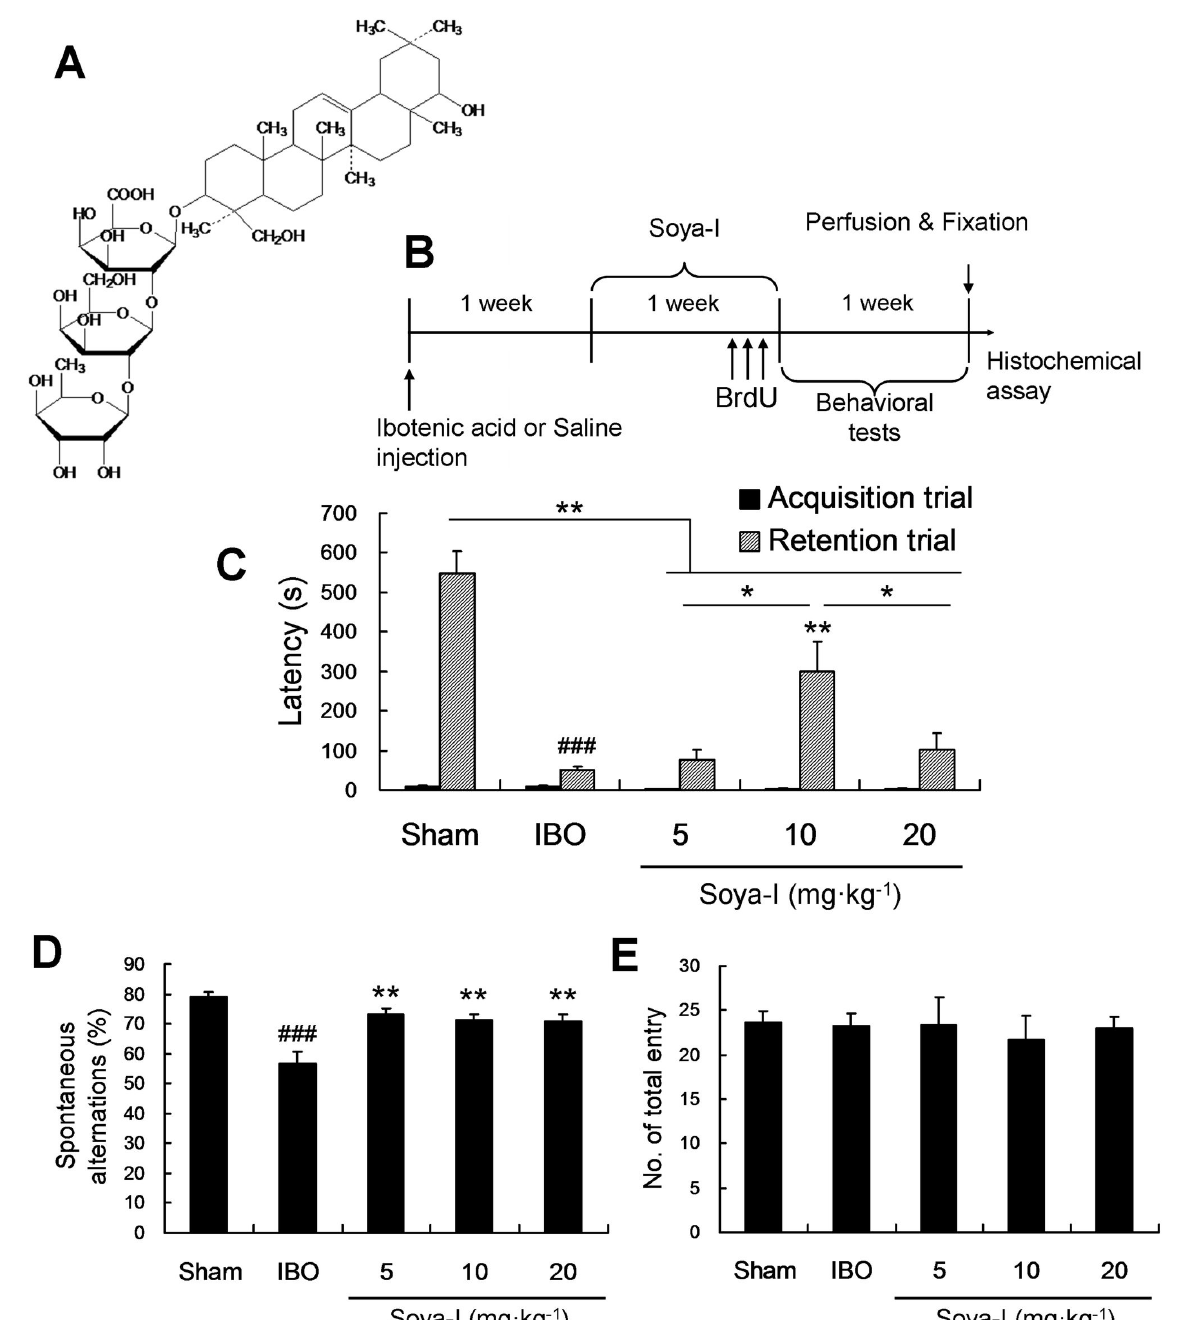
Figure 1. Effects of soyasaponin Ι (soya-Ι) on memory behaviors in ibotenic acid induced model rats. A. Structure of soya-I isolated from soybean ( Glycine Max Marr., family: Leguminosae), B. time line of experimental procedures for the investigation of proliferation and differentiation, and behavioral effects of soya-I. Rats were orally administered soya-Ι (5, 10, and 20 mg·kg -1 , p.o.) or vehicle (same volume, p.o.) once per day for 7 days, and the passive avoidance tests (C) and Y-maze tests (D) were carried out 1 week later. Rats were orally administered soya-Ι (10 mg·kg -1 , p.o.) or vehicle (same volume, p.o.) once per day for 7 days. The sham group was injected with saline instead of IBO. C. Latency times in the passive avoidance test, D. spontaneous alterations, and E. number of total entry in the Y-maze test during 8-min sessions were measured as described in Materials and Methods. Data represent means ± standard error of the mean (SEM). ### p < 0.001, compared with the sham group; * p < 0.05, ** p < 0.01, compared with the IBO group by the Newman-Keuls Multiple Comparison Test. doi: 10.1371/journal.pone.0081556.g001 PLOS ONE |